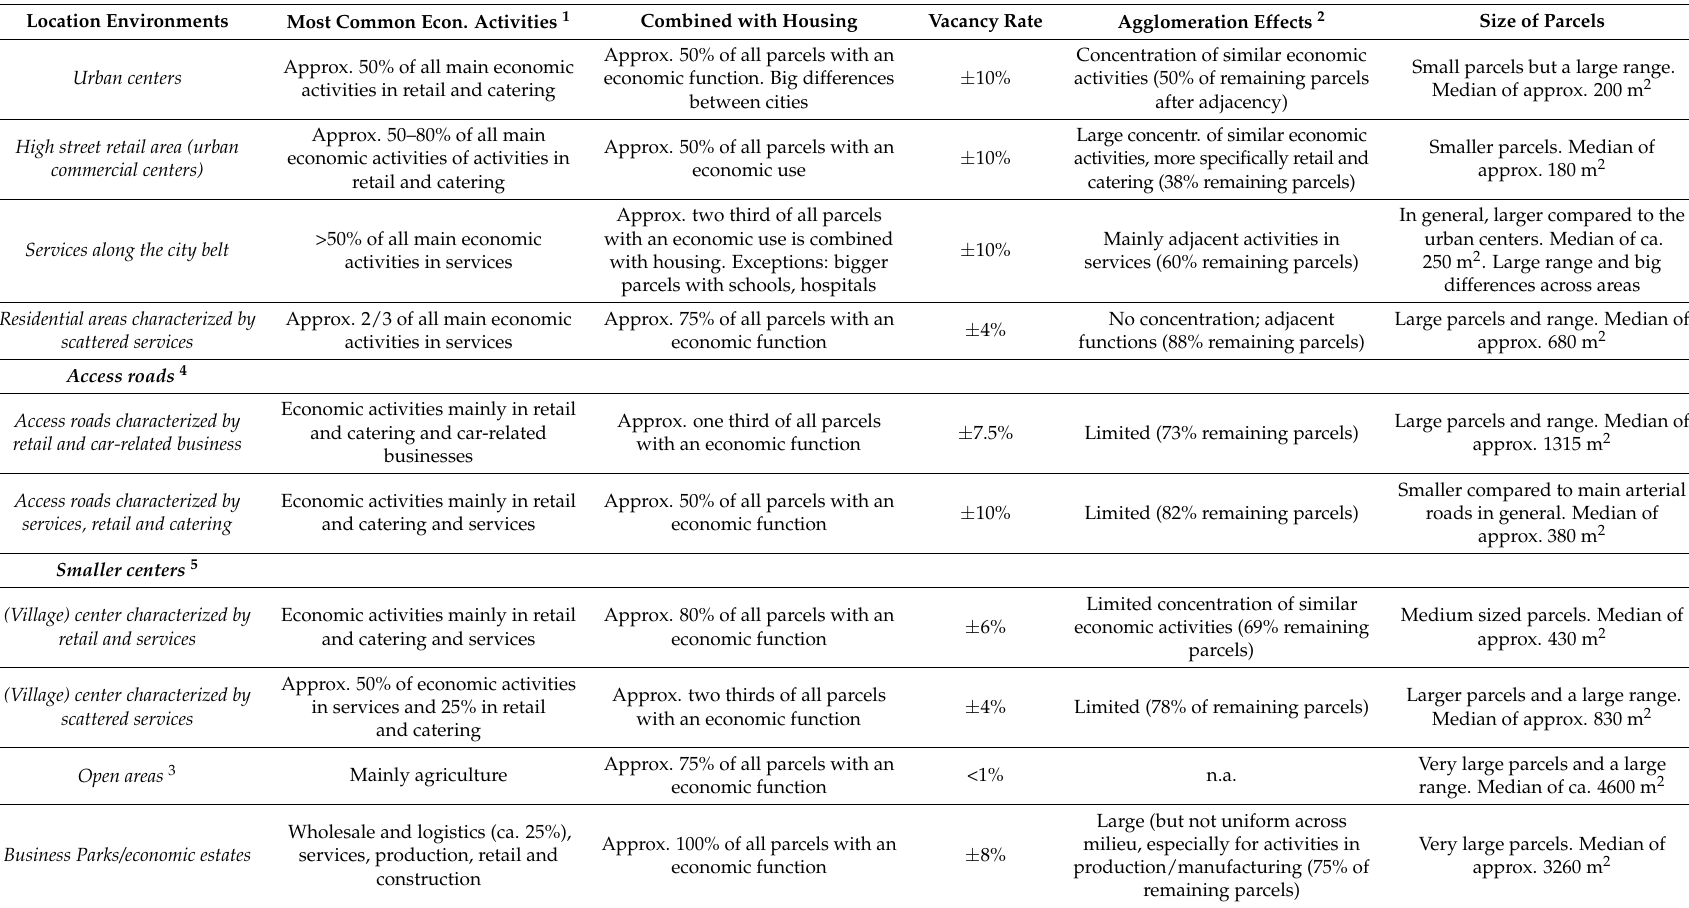
Table 3. Eight location environments identified (based on field inventory in 5 case study